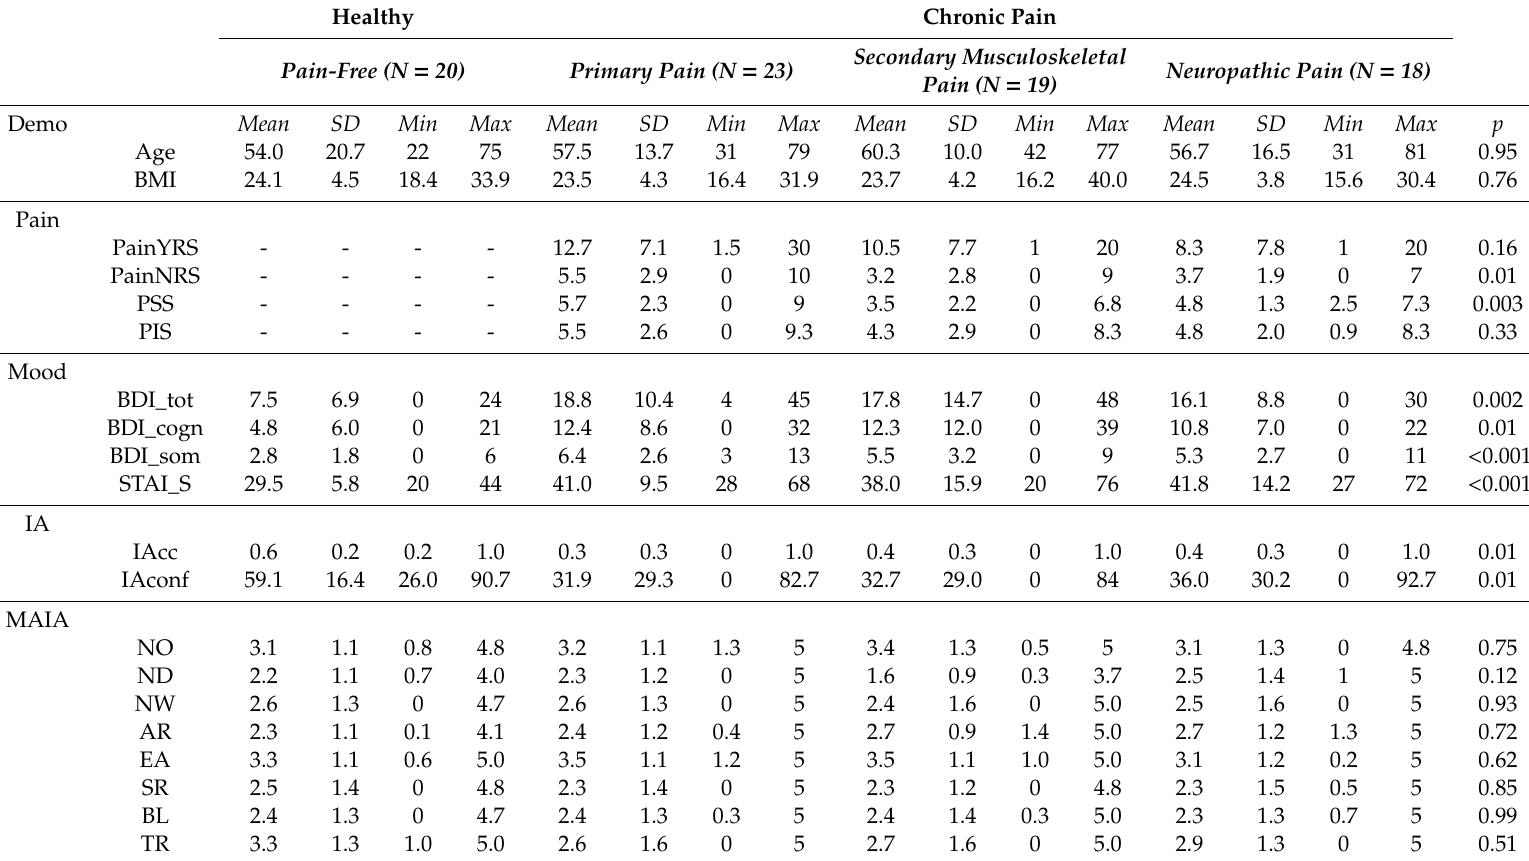
Table 2. Sample characteristics and principal variables of